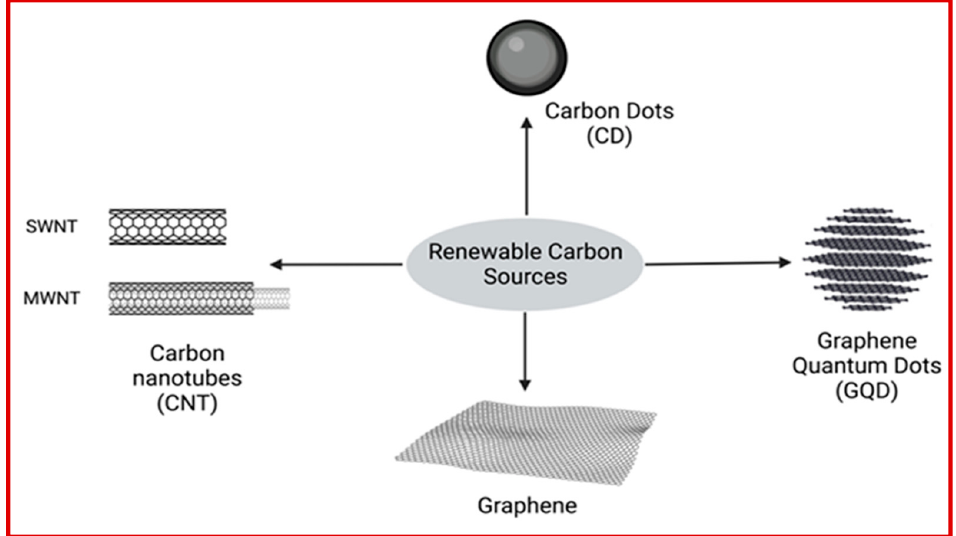
Figure 4. Sustainable production of different carbonaceous nanomaterials (CNMs) from renewable carbon resources.